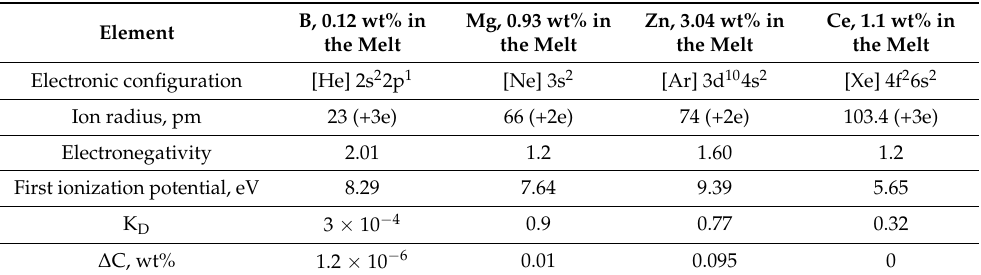
Table 4. Concentration characteristics of LN doped with dopants with different electronic configura- tion. Table is reproduced with the permission of Pleiades Publishing from the paper O.V. Makarova et al., Techn. Phys . 2019 V. 64 P. 1872–1878, DOI: https://doi.org/10.1134/S1063784219120168 (ac- cessed on 26 March